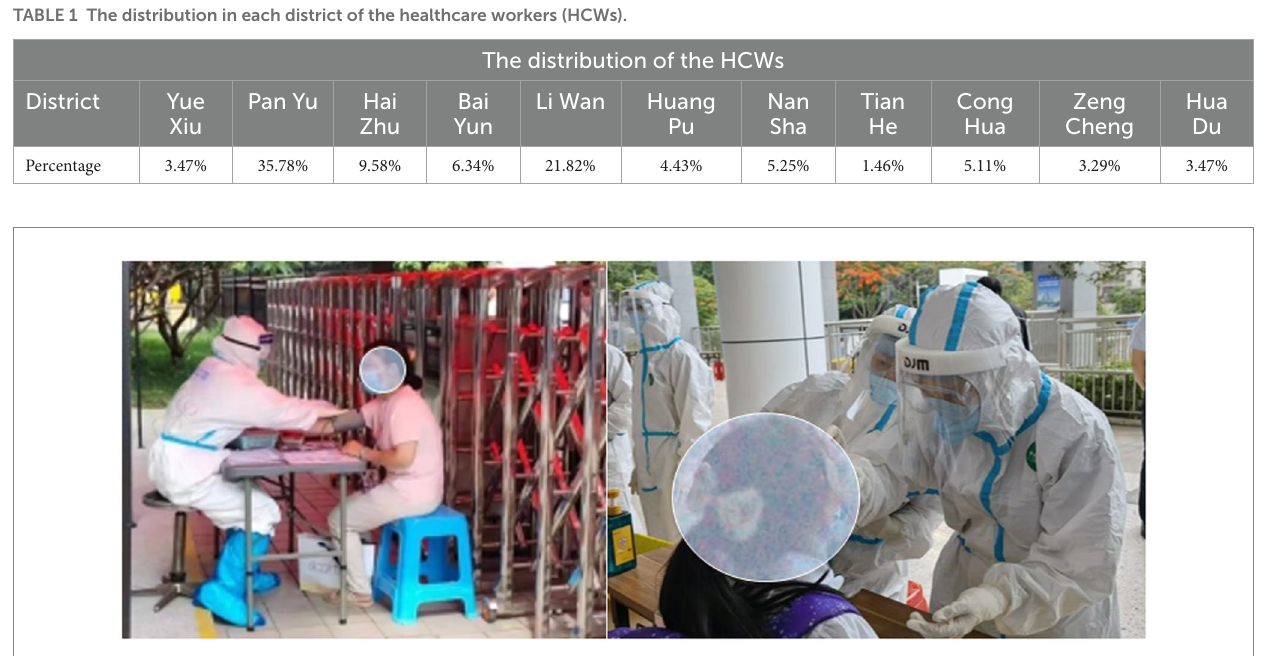
FIGURE 3 Health staff conducting nucleic acid sampling at a site.